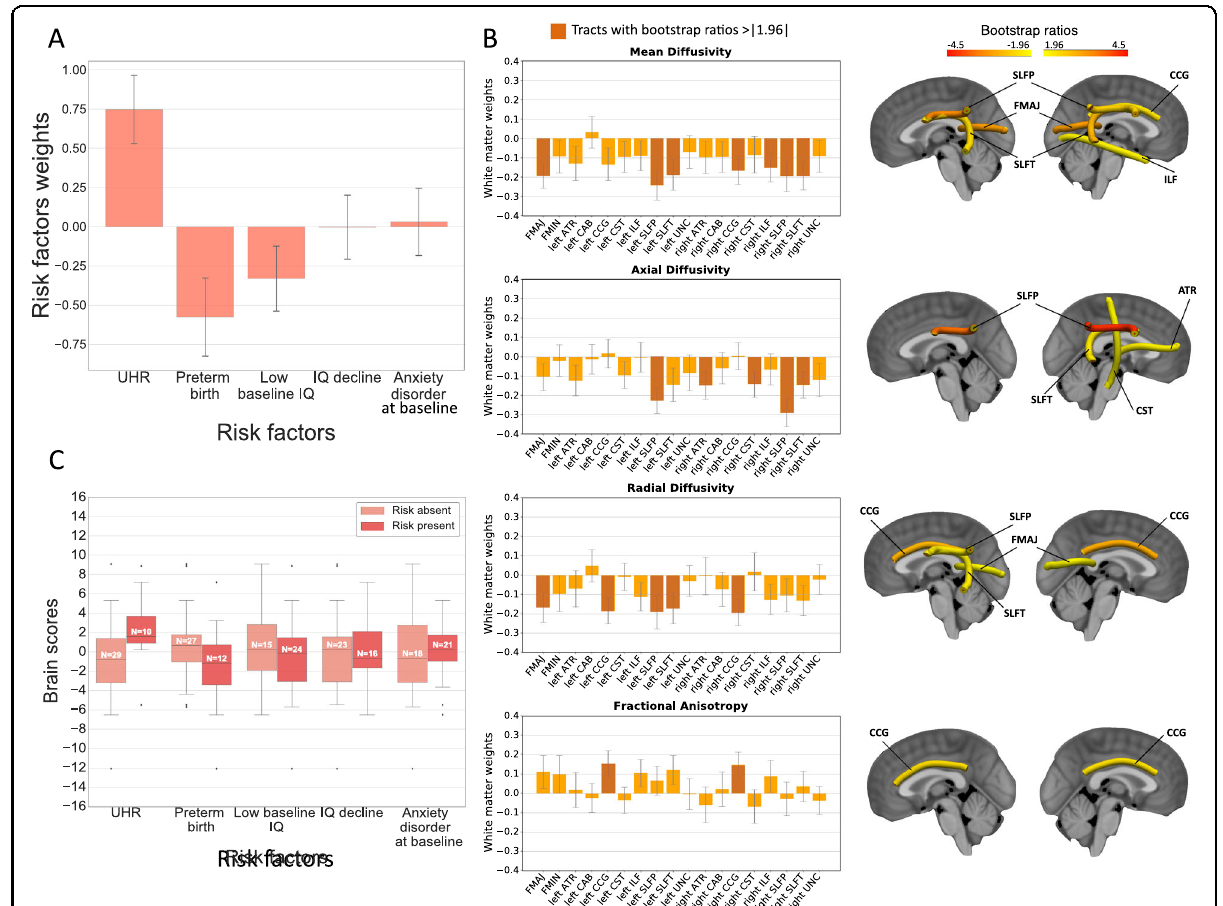
Fig. 5 Relationship between clinical risk factors of psychosis and white matter microstructure in 22q11.2DS captured through PLS correlation. PLS correlation analysis between white matter microstructure and clinical risk factors of psychosis in subjects with 22q11.2DS revealed one signi fi cant correlation component ( r = 0.48, p = 0.027), as evaluated by permutation testing (threshold of p < 0.05). A Corresponding behavior weights of risk factors are displayed with bootstrap error bars; B brain white matter weights are represented with bootstrap error bars. Tracts that most heavily contribute to the brain-behavior correlation, that is, with bootstrap ratios >1.96 or < − 1.96 (corresponding to a robustness at a con fi dence interval of 95%) are highlighted in darker orange in the graphs and displayed in the brain renderings, where tracts with orange to red colors contribute most strongly to the brain-behavior correlation; C fi nally, brain scores are plotted for groups of patients carrying (risk present) or not (risk absent) a given risk factor. The correlation pattern reveals that the UHR status, preterm birth, and low baseline IQ strongly contribute to the brain- behavior pattern. Interestingly, patients at UHR present opposite tendencies of brain alterations (reduced AD, RD, MD, and increased FA) compared to subjects born preterm or with a low IQ at baseline (increased AD, RD, MD, and decreased FA). White matter tracts furthermore present consistent and widespread alterations affecting multiple tracts and all four diffusion metrics. lh left hemisphere, rh right hemisphere, FMAJ forceps major (corpus callosum), FMIN forceps minor (corpus callosum), ATR anterior thalamic radiation, CAB cingulum – angular bundle, CCG cingulum – cingulate bundle, CST corticospinal tract, ILF inferior longitudinal fasciculus, SLFP superior longitudinal fasciculus – parietal bundle, SLFT superior longitudinal fasciculus – temporal bundle, UNC uncinate